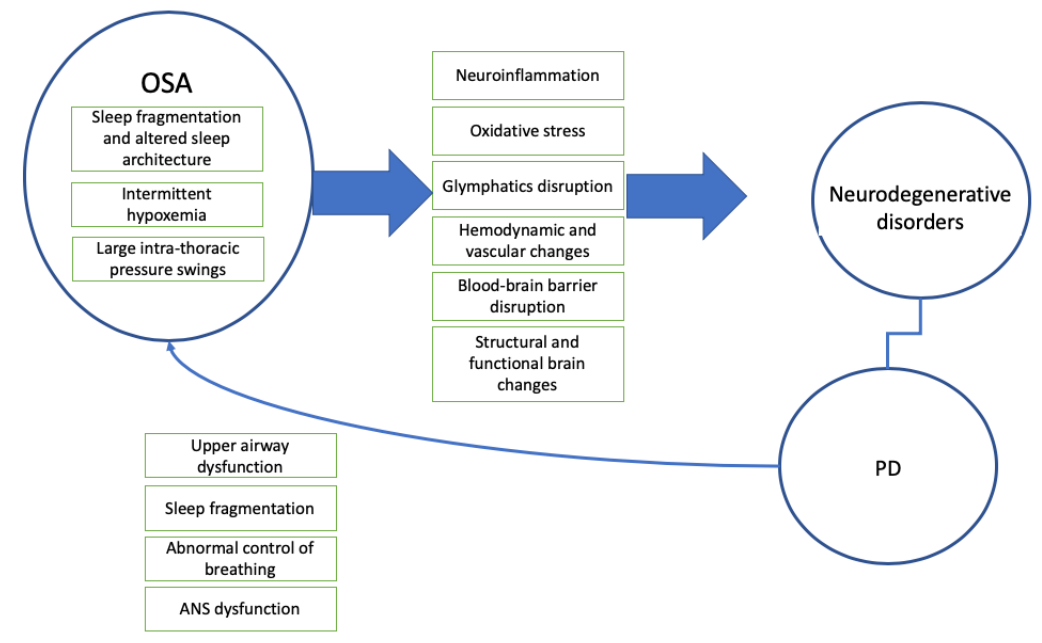
Figure 1. The relationship between obstructive sleep apnea, neurodegenerative disorders, and Parkinson’s disease. OSA, obstructive sleep apnea, and PD, Parkinson’s